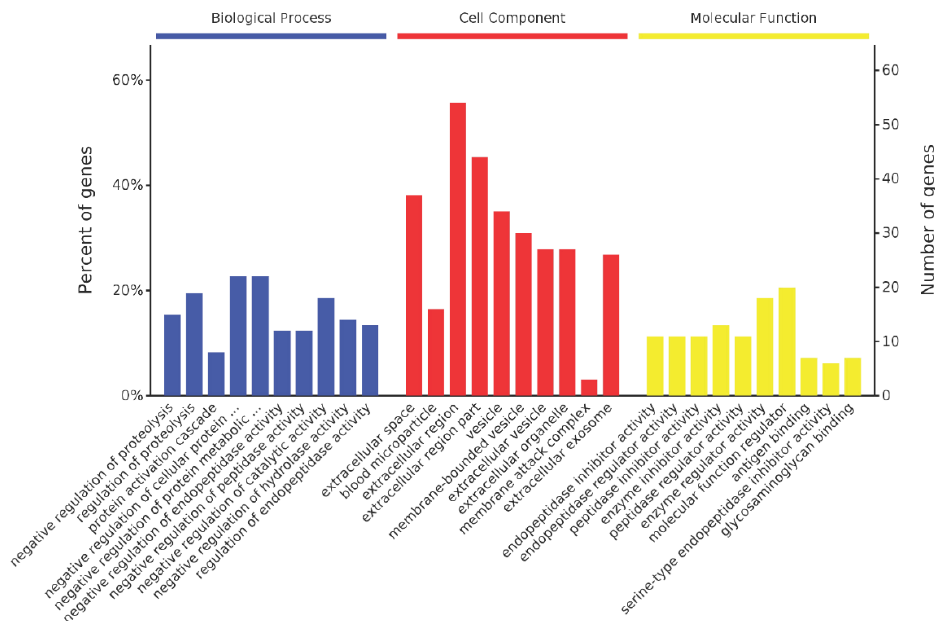
Figure 7. LC-MS/MS and GO analysis of NnTXs antiserum. All the identified proteins were classified as cellular component, biological process, or molecular function.